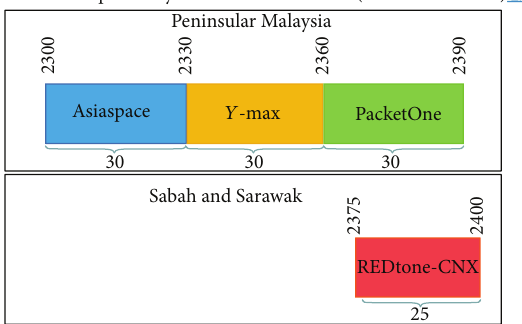
Figure1:MalaysianSpectrumAllocationChartofWiMAX2.3 GHz